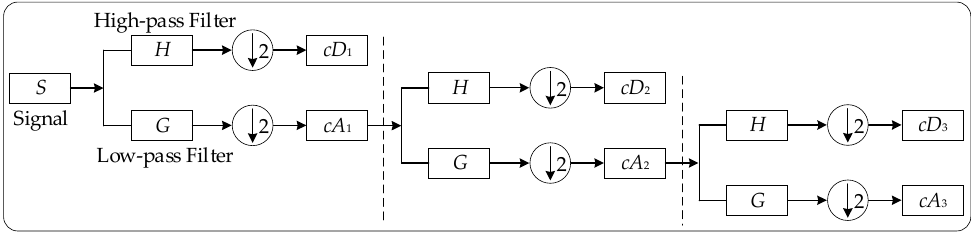
Figure 1. Three level decomposition of 1-D signal.